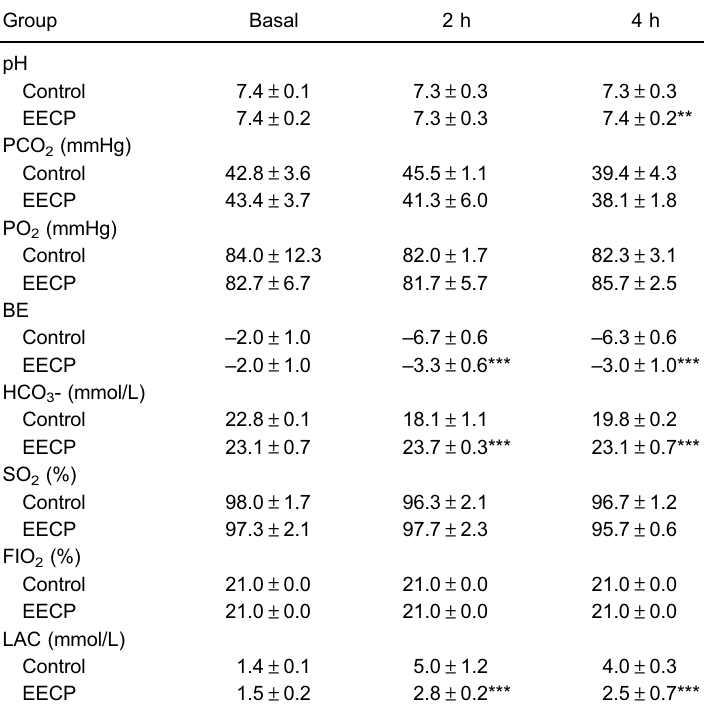
Table 1. Blood gas parameters at baseline and at 2 and 4 h after return of spontaneous circulation in Control and enhanced external counterpulsation (EECP)